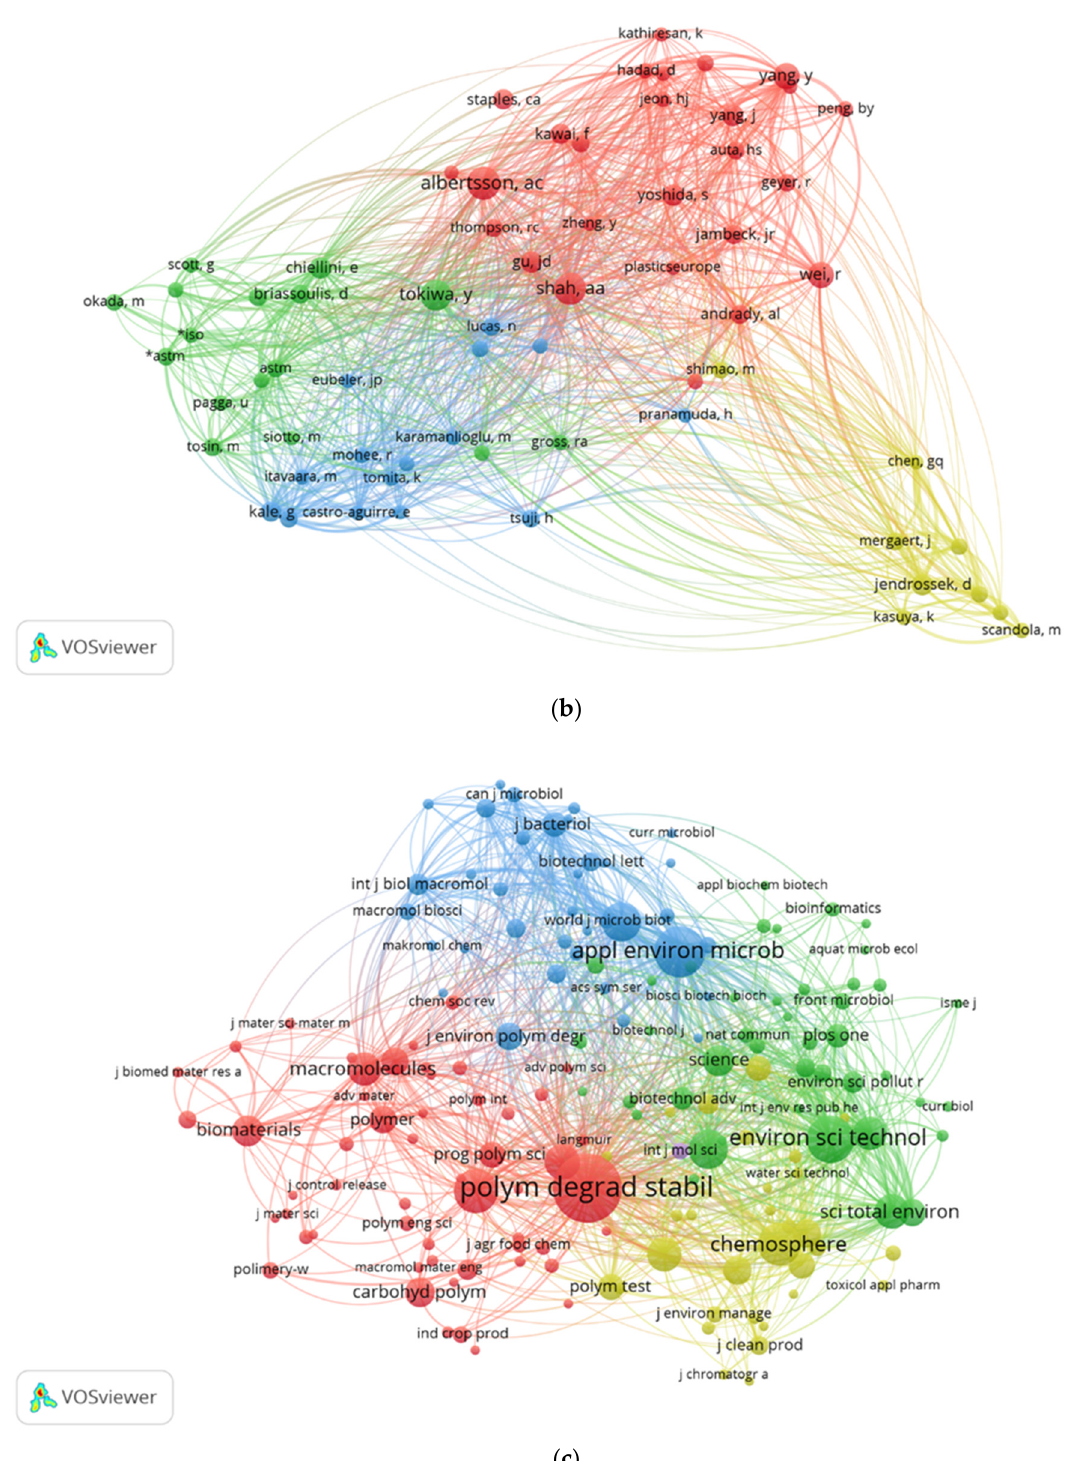
Figure 5. ( a ). Co-citation of cited references in biodegradation-of-plastics-related research between 2000 and 2021. ( b ). Co-citation of cited authors in biodegradation-of-plastics-related research between 2000 and 2021. ( c ). Co-citation of cited sources in biodegradation-of-plastics-related research between 2000 and 2021.